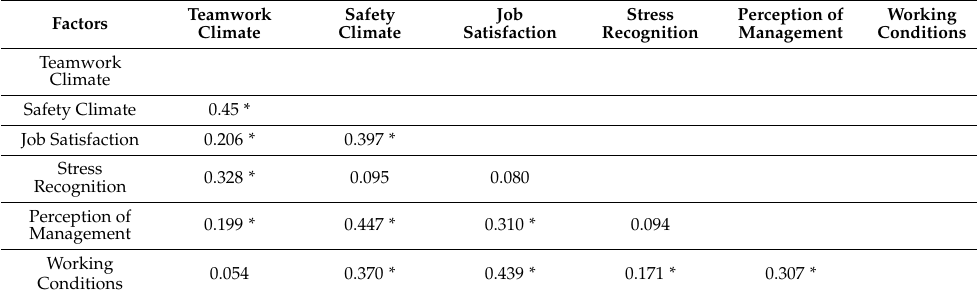
Table 4. Inter-correlations of the six